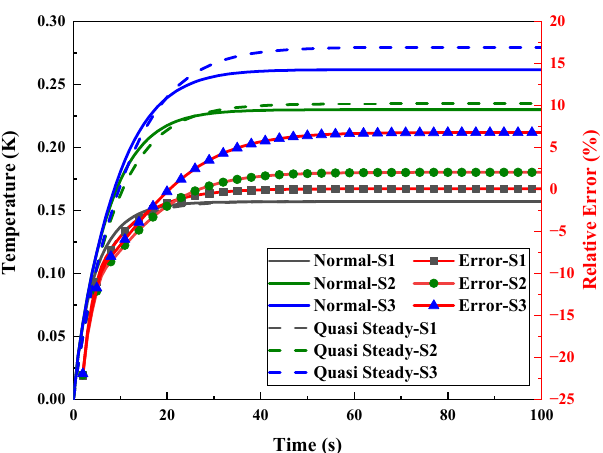
Figure 7. The average temperature variation curves of the three rectangular block surfaces with the quasi-steady and traditional coupling algorithms, and the error of the quasi-steady algorithm relative to the traditional coupling algorithm.